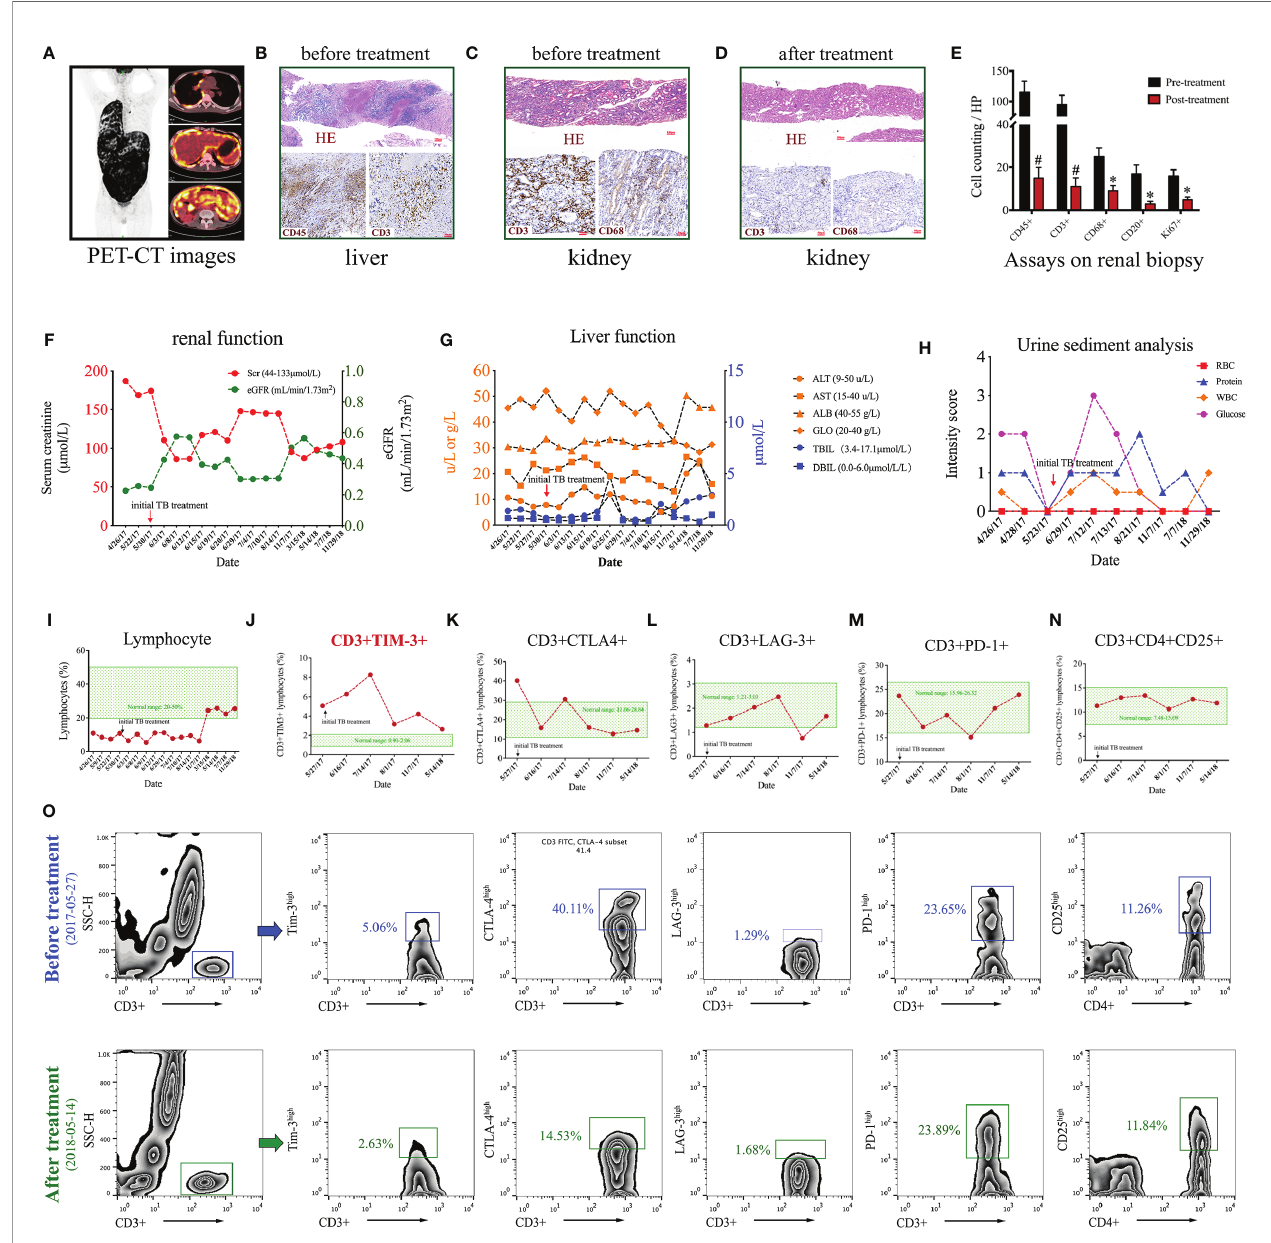
FIGURE 1 | Clinical data of a case of Mycobacterium tuberculosis (Mtb) infection. (A) PET-CT images. (B) Liver biopsy before anti-Mtb treatment with HE and immunohistochemical staining using antibodies against CD45 and CD3. (C – E) Renal biopsies before (C) and after (D) anti-Mtb treatment and quantitative analysis (E) on kidney interstitial cells by expressions of CD45, CD3, CD68, CD20, and Ki67. (F – I) Time-course of renal function (F) , liver function (G) , urine sediment (H) , and circulating lymphocyte ratio (I) . (J – N) Time-course of fl ow cytometry assays on different subsets of circulating T cells, including CD3+TIM 3+ (J) , CD3+CTLA-4+ (K) , CD3+LAG-3+ (L) , and CD3+PD1+ (M) , and CD3+CD4+CD25+ (N) . (O) Gating strategies and representative fi gures of fl ow cytometry assays. *P < 0.01, # P <